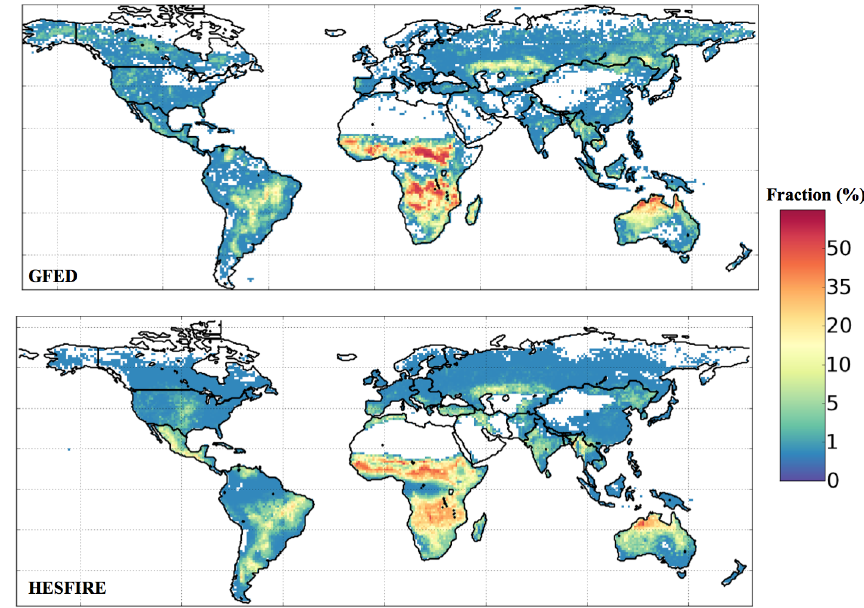
Figure 6. Observed and modeled average annual burned fraction. Top: GFEDv3 burned areas on “natural” landscapes. Bottom: fire model.